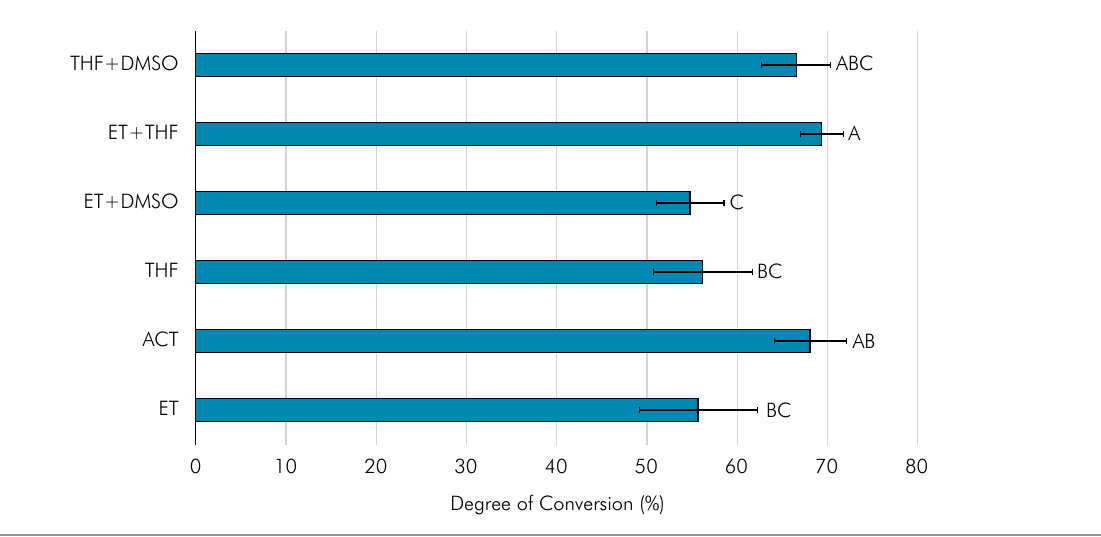
Figure 1. Results of viscosity analysis.